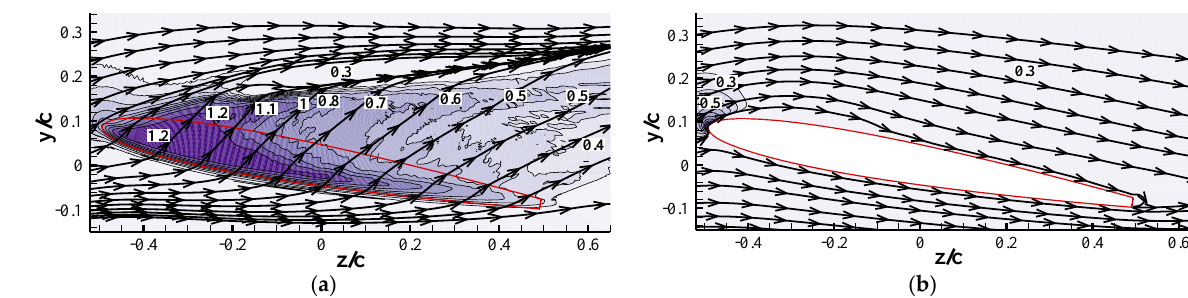
Figure 12. Pitchwise velocity distributions normalized by the inflow velocity and the streamlines in y-z planes: ( a ) x / c = 0.01, and ( b ) x / c = 0.2.